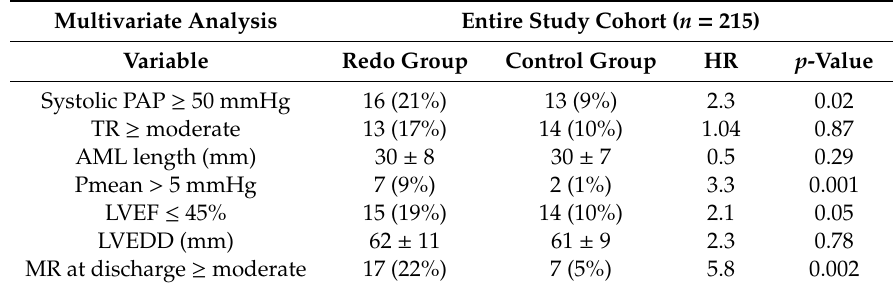
Table 2. Echocardiographical risk factors for redo mitral valve (MV) surgery in the whole study cohort (Cox regression model). Parameters were collected prior to initial mitral valve